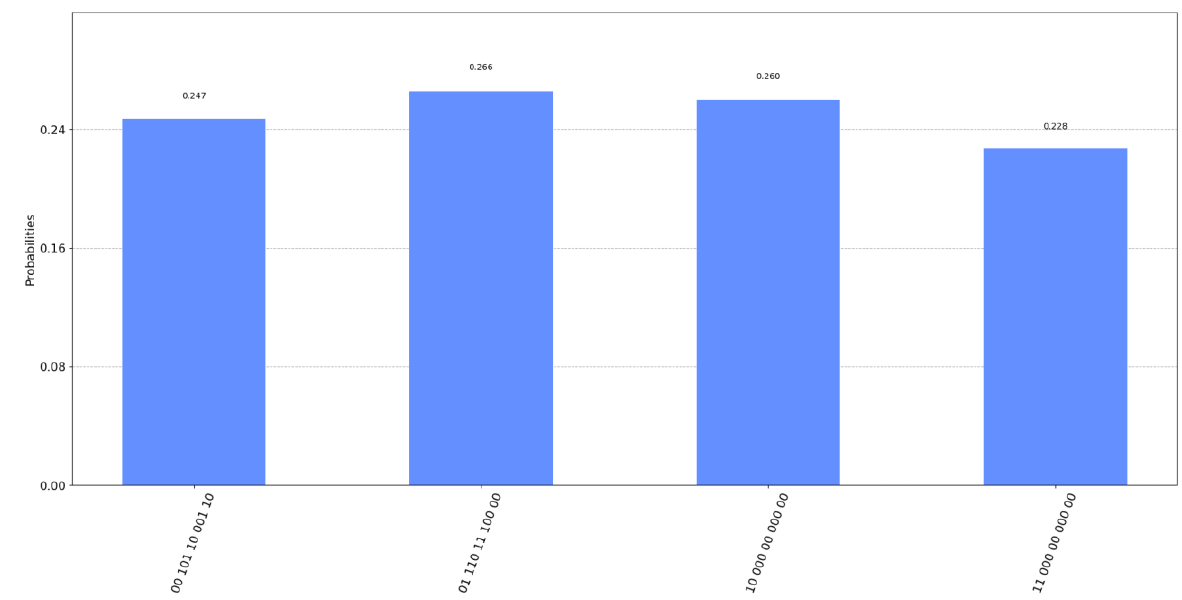
Figure 8. The probability histogram for the alternative exchange circuit.